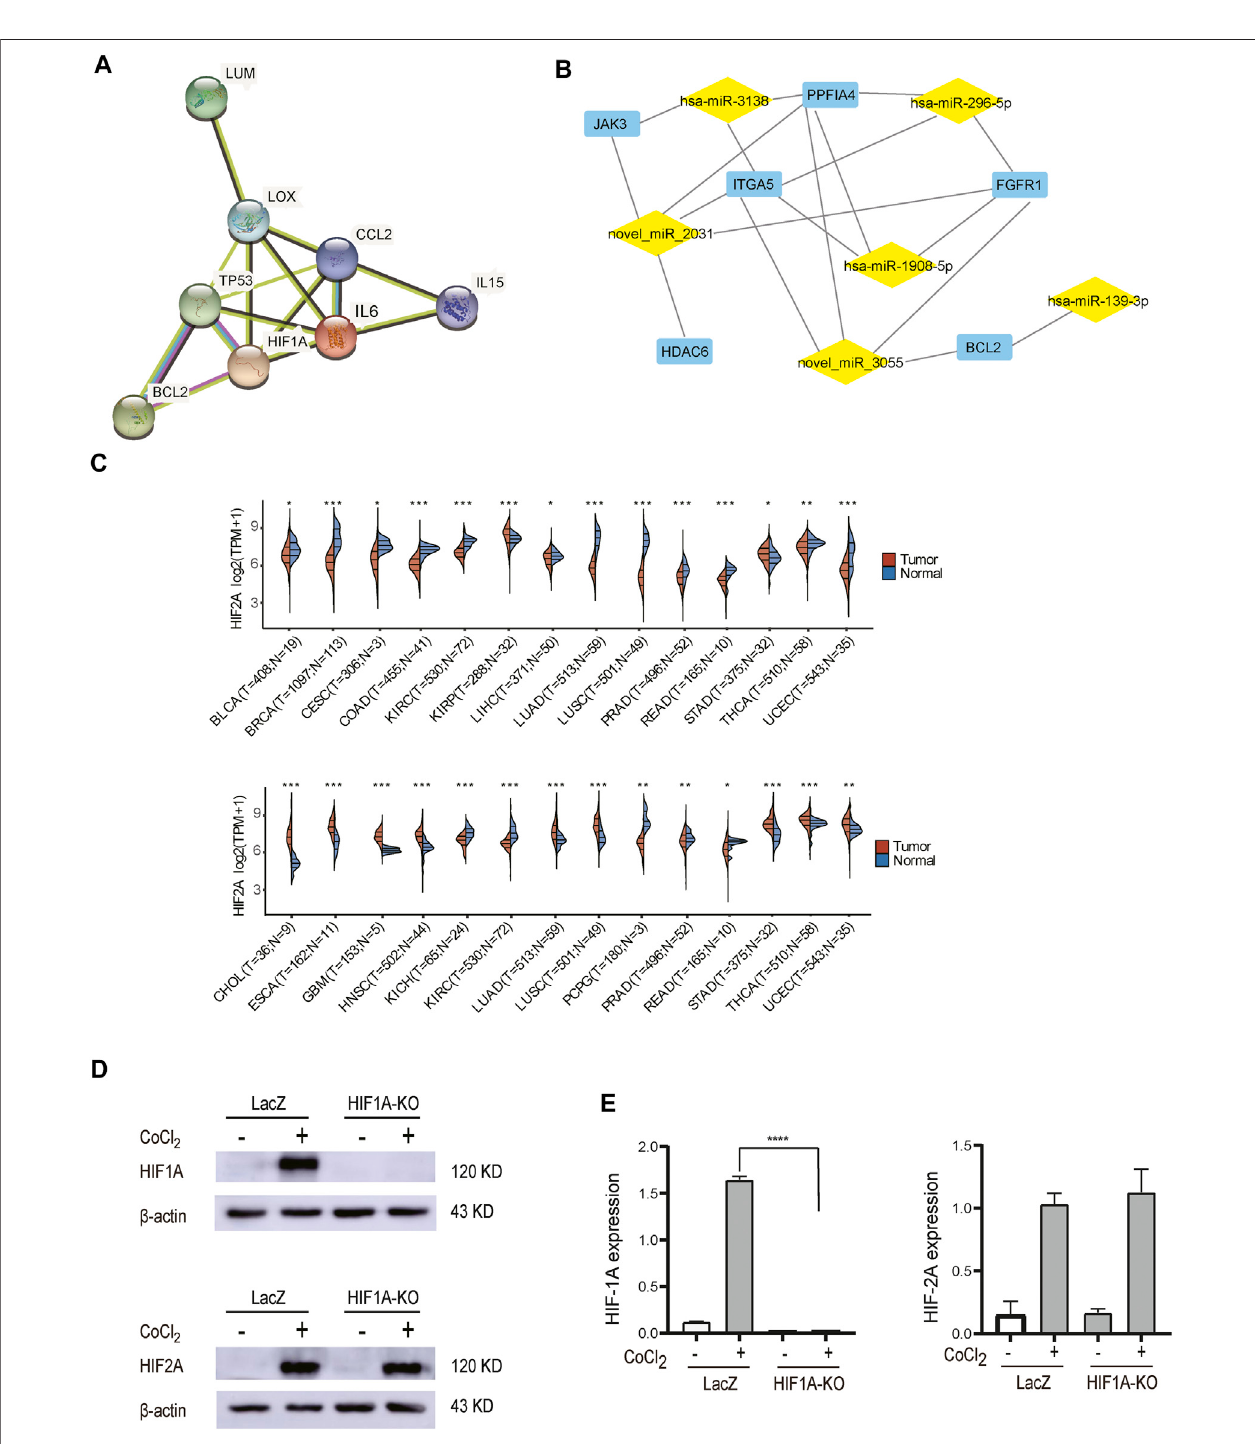
FIGURE7| Potentialmechanistic. (A) PPIofhubgenes. (B) PutativemiRNA – mRNAcorrelationnetwork.ExpressionofHIF1Aand HIF2Ainpan-carcinomatissues (* p < 0.05,** p < 0.01,*** p < 0.001). (D) ExaminationofHIF2AproteinexpressionincontrolcellsandHIF1A-KOcellsbyWesternblot. (E) TheHIF2AexpressionofHIF1A- KO and LACZ-control HepG2 cells was not changed signi fi cantly (**** p < 0.0001).